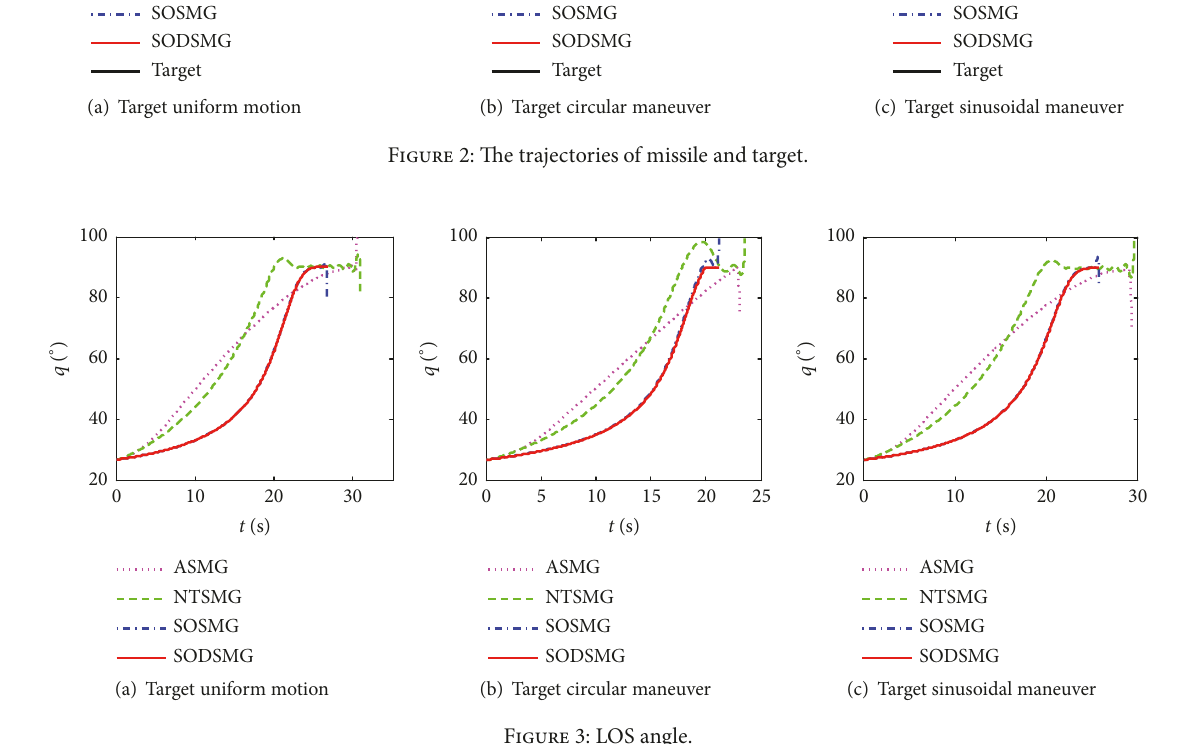
Figure 3: LOS angle.